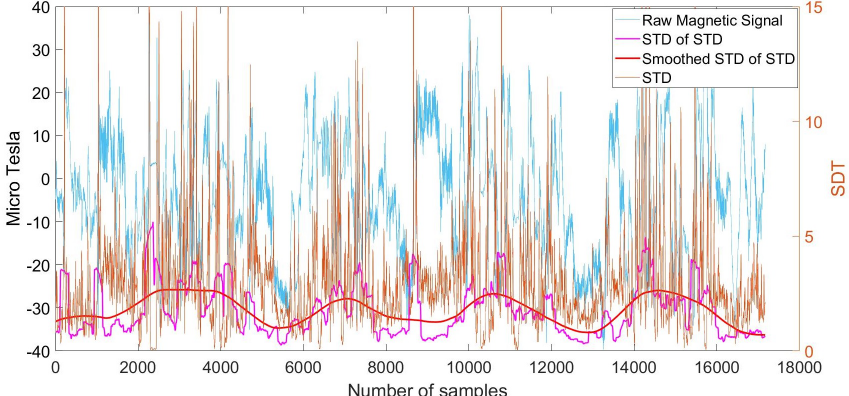
Figure 9. Magnetometer signal from walking into four consecutive buildings and corresponding smoothed moving Standard Deviation (STD) of moving STD with kernel size of